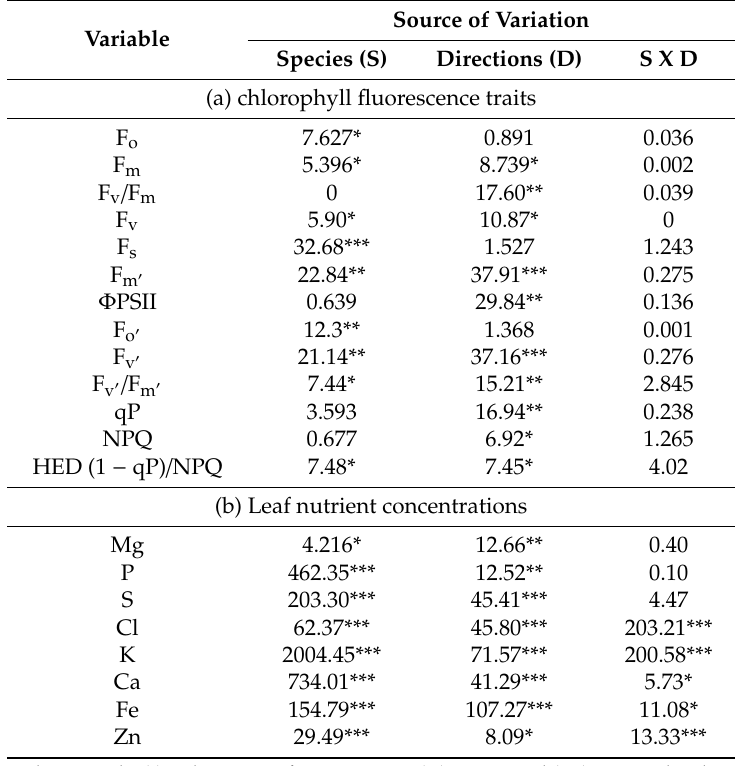
Table 2. ANOVA (F-values) testing the e ff ects of Prosopis species ( P. cineraria and P. juliflora ) and canopy position (southeast and northwest) on (a) several chlorophyll fluorescence traits and (b) leaf nutrient concentrations. The numerator and denominator degrees of freedom are 1 and 8, respectively. Source of Variation Variable Species (S) Directions (D) S X